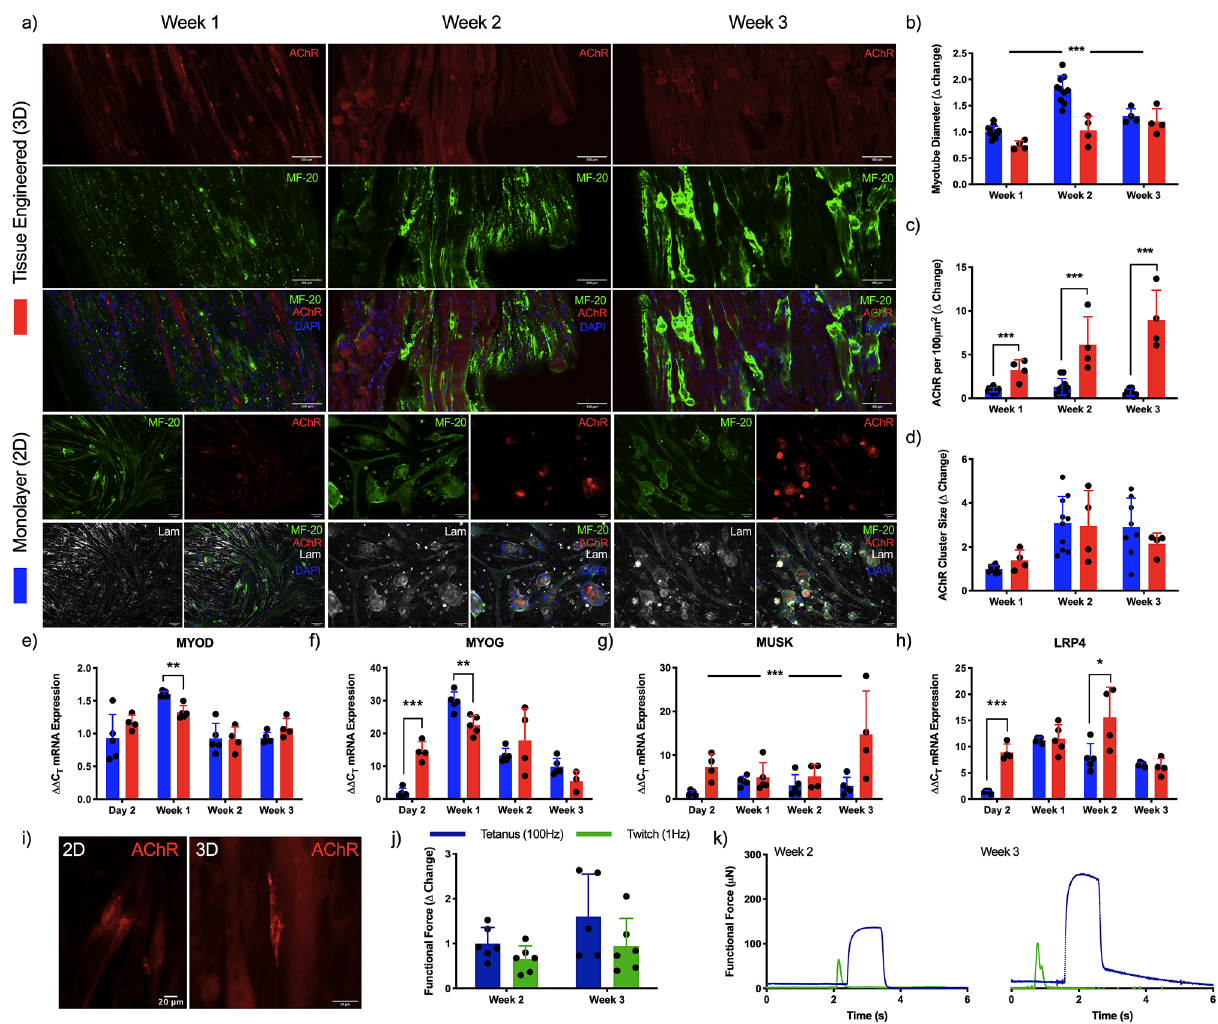
Figure 4. 3D culture of primary human skeletal muscle enhances acetylcholine receptor clustering, produces functional force and upregulates transcription of post-synaptic mRNAs. ( a ) Confocal tile scans of single z-plane (Tissue engineered 3D) and fluorescence images (Monolayer 2D) of human skeletal muscle labelled for AChR on the post-synaptic membrane, pan-myosin heavy chain (MF-20), laminin (monolayer only) and nuclear DNA (DAPI) across 1, 2 and 3 weeks culture. Morphological analysis of ( b ) myotube diameter, ( c ) AChR density and ( d ) cluster size. Transcriptional analysis of myogenic; ( e ) MYOD and ( f ) MYOG, and post-synaptic; ( g ) MUSK and ( h ) LRP4 mRNAs. Blue bars = Monolayer (2D), Red bars = Spheroid (3D). ( i ) Zoom images of AChR in monolayer (2D) and tissue engineered (3D) skeletal muscle. ( j ) Functional tetanus and twitch force data and ( k ) representative traces in engineered tissues. Δ change indicative of normalised data to the earliest monolayer time-point. Beginning of representative tetanus and twitch contractions represents initiation of electrical field stimulation, time elapsed before this point is un-stimulated baseline recording. Data presented ± standard deviation (SD). *P ≤ 0.05, **P ≤ 0.01 and ***P ≤ 0.001. Scale bars = (a) 100 µm, (i) 20